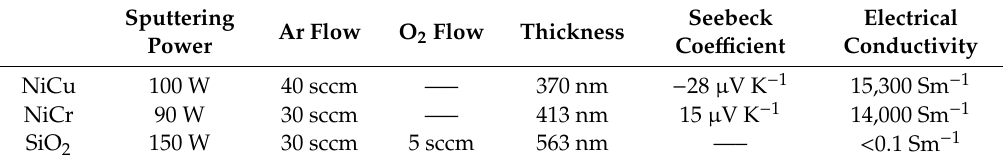
Table 1. The detail preparing parameters and properties of the thin